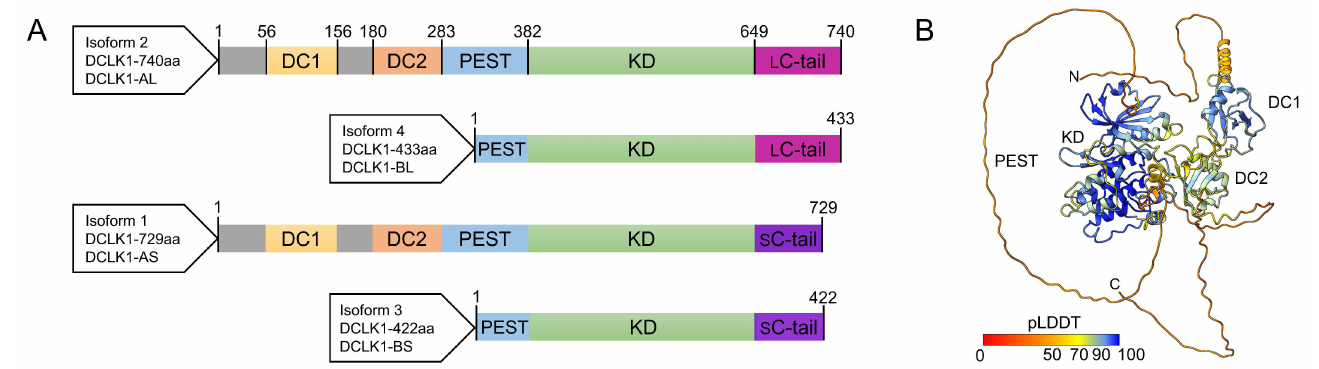
Figure 1. Doublecortin-like kinase 1 (DCLK1) structure and domain organization: ( A ) schematic overview of the four DCLK1 isoforms and domain boundaries comprising the two tandem dou- blecortin (DC) domains (yellow/orange), the proline, glutamic acid, serine, and threonine rich (PEST) linker-region (light blue), the S/T-kinase domain (KD, light green), and the short (S, purple) and long (L, magenta) regulatory C-terminal tail (C-tail); and ( B ) cartoon representation of the AlphaFold2 model of DCLK1 (Isoform 2, O15075) colored according to confidence (Predicted Local Distance Difference Test—pLDDT) (AlphaFold2 [63,64]). Regions with a pLDDT value of < 50 are likely disor- dered and the positions of corresponding amino acids relative to domains are uncertain.